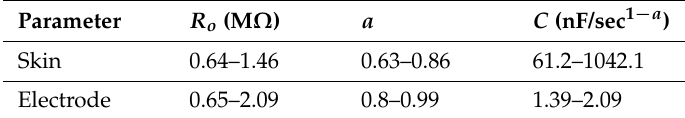
Table 2. Indicative skin and electrode Cole model parameter range